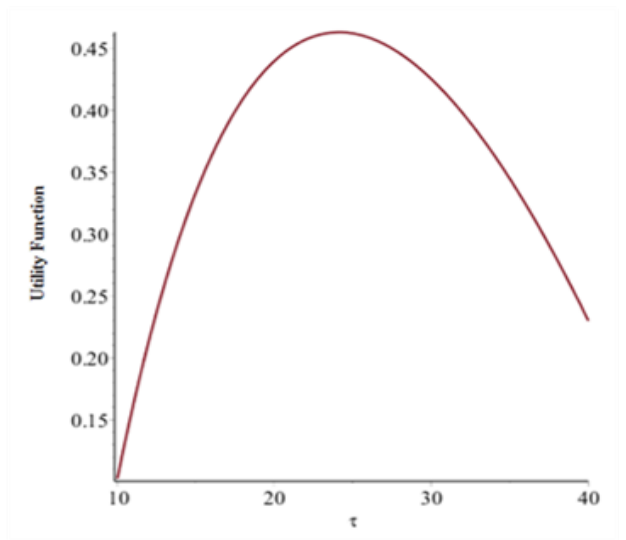
Figure 4. Concavity plot under no field-testing (NFT) release time